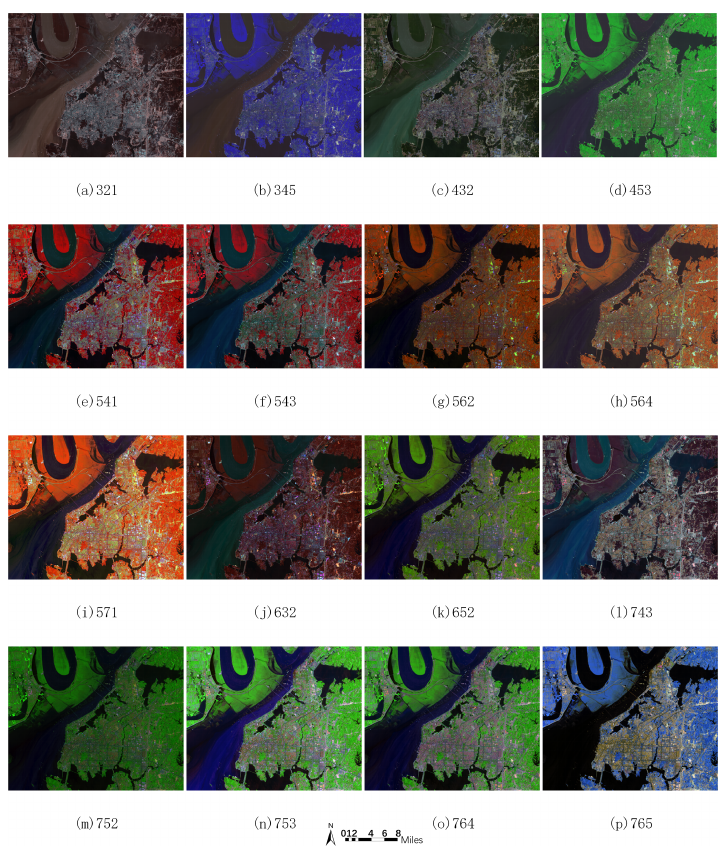
Figure 3. From image ( a – p ) are band 321, 345, 432, 453, 541, 543, 562, 564, 571, 632, 652, 743, 752, 753, 764, 765 composition in 2017,